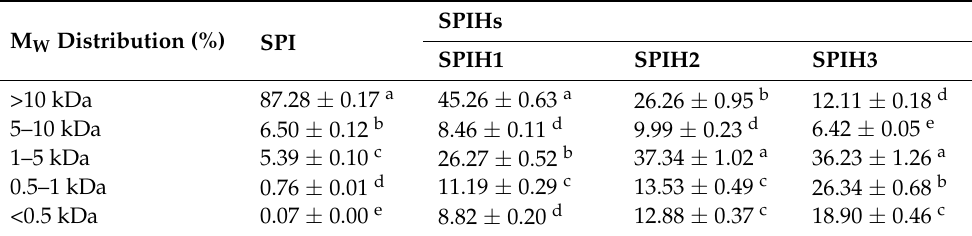
Table 1. The molecular weight (MW) distributions of soy protein isolate (SPI) and its hydrolysates